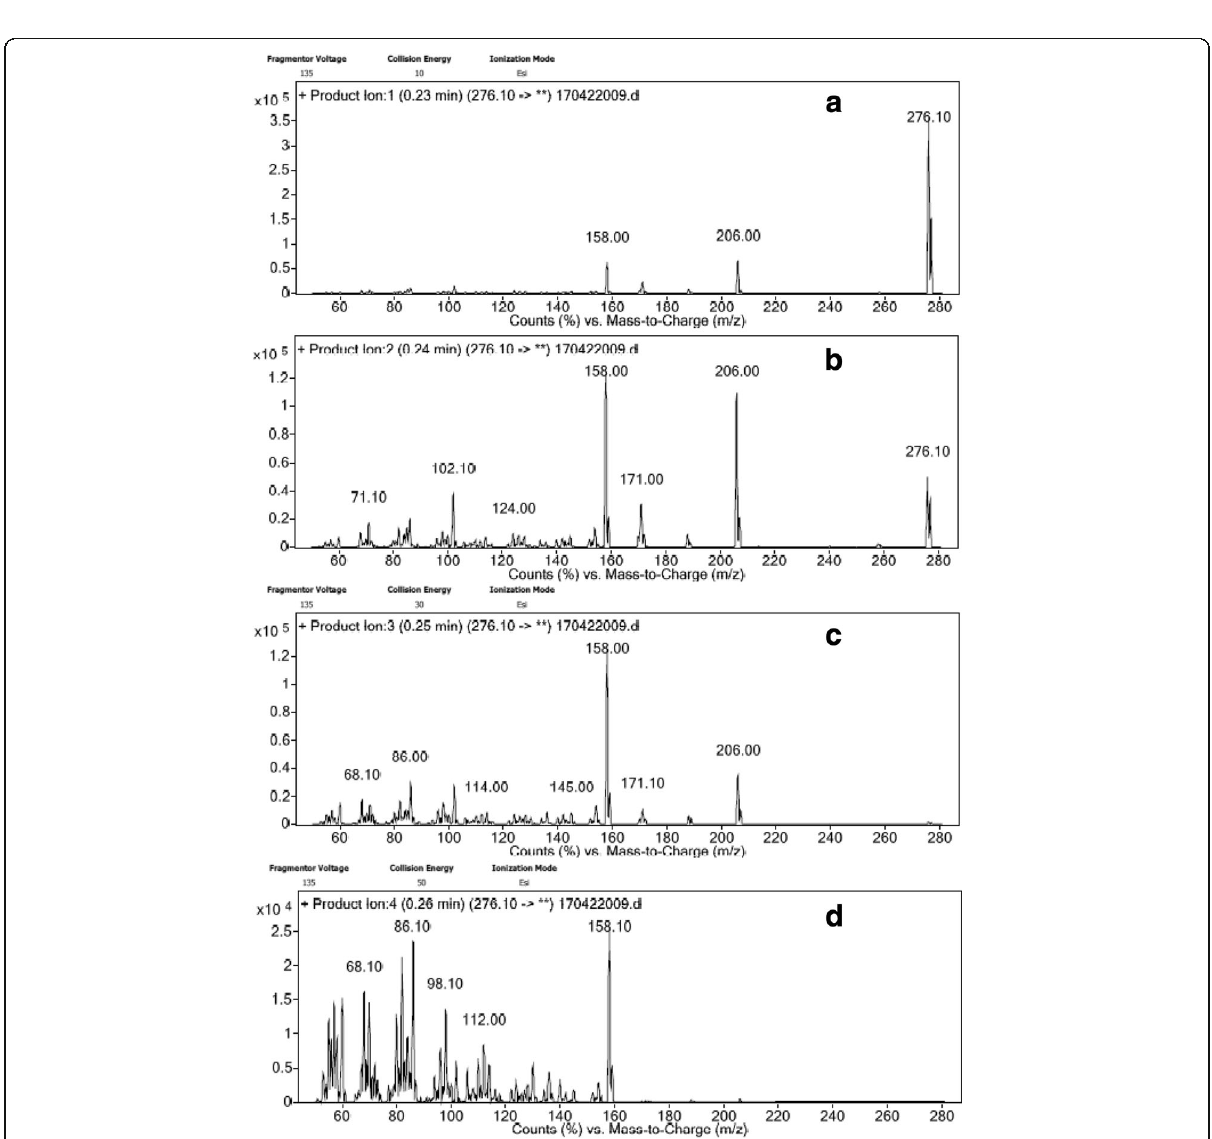
Fig. 10 MS/MS of n-oxide impurity of celgosivir at a 10 eV collision energy, b 20 eV collision energy, c 30 eV collision energy, and d 50 eV collision